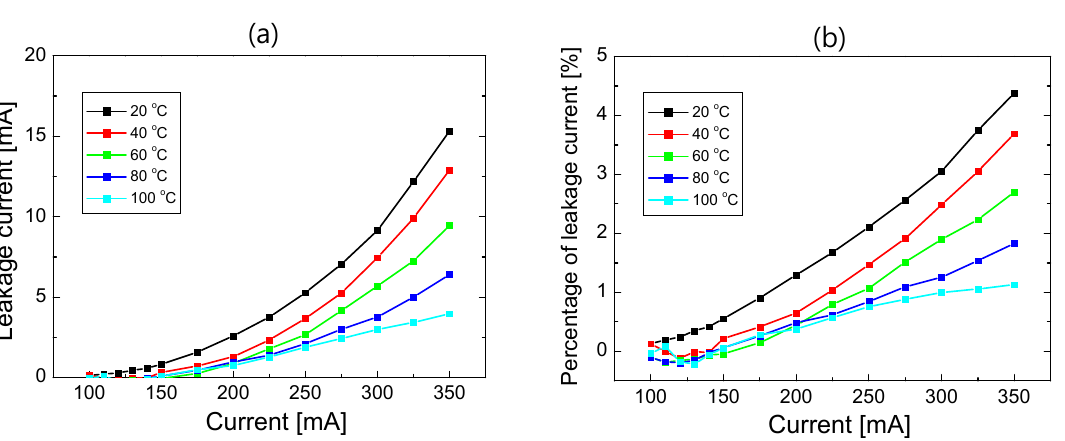
Figure 3. ( a ) Leakage current as a function of injection current and ( b ) the percentage of electron leakage current ( P leak ) as a function of injection current at temperatures of 20, 40, 60, 80, and 100 °C.